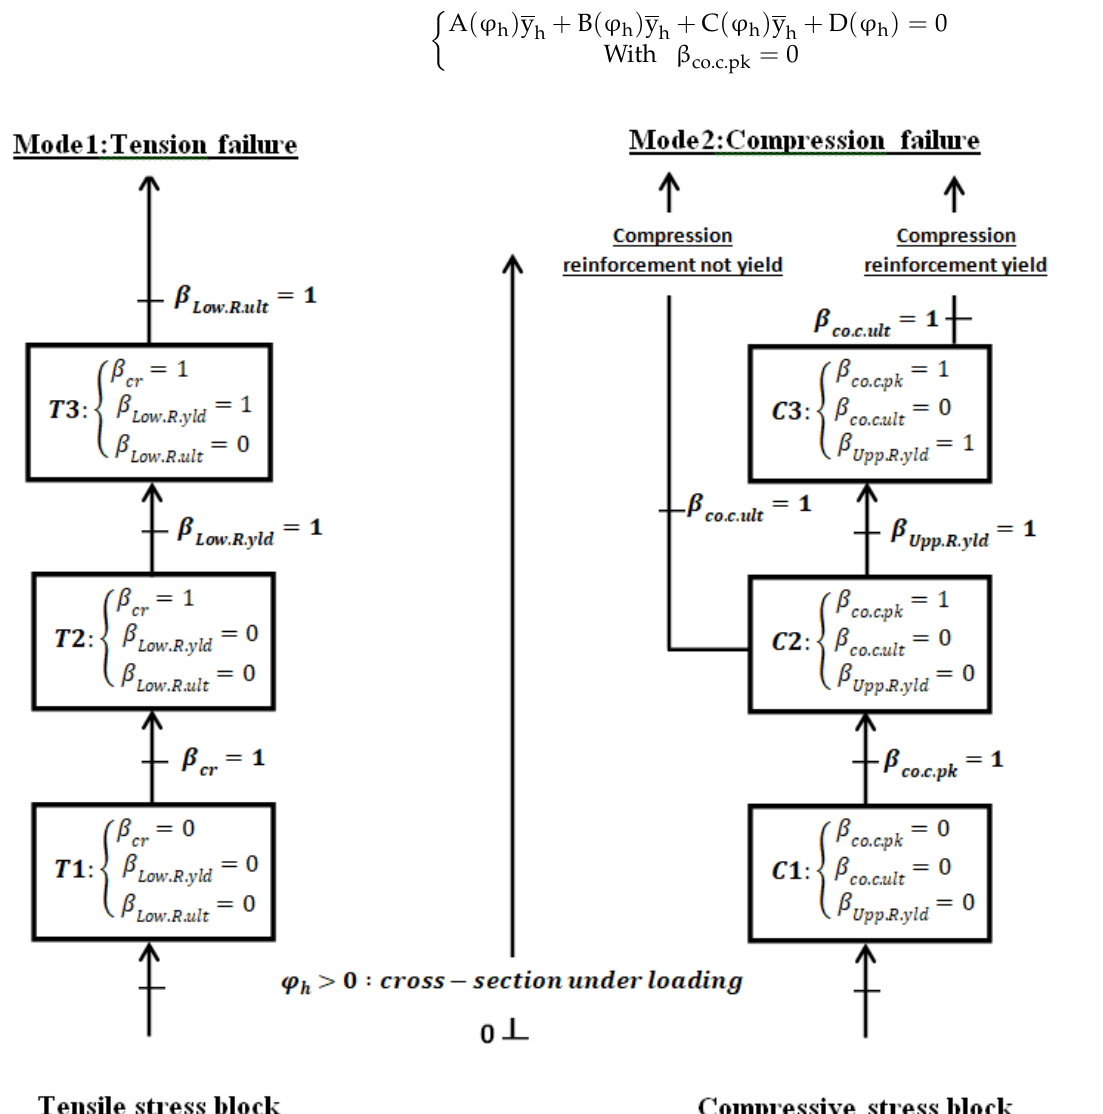
Figure 13. Deformation processes in blocks of tensile and compressive stress under increasing curvature.